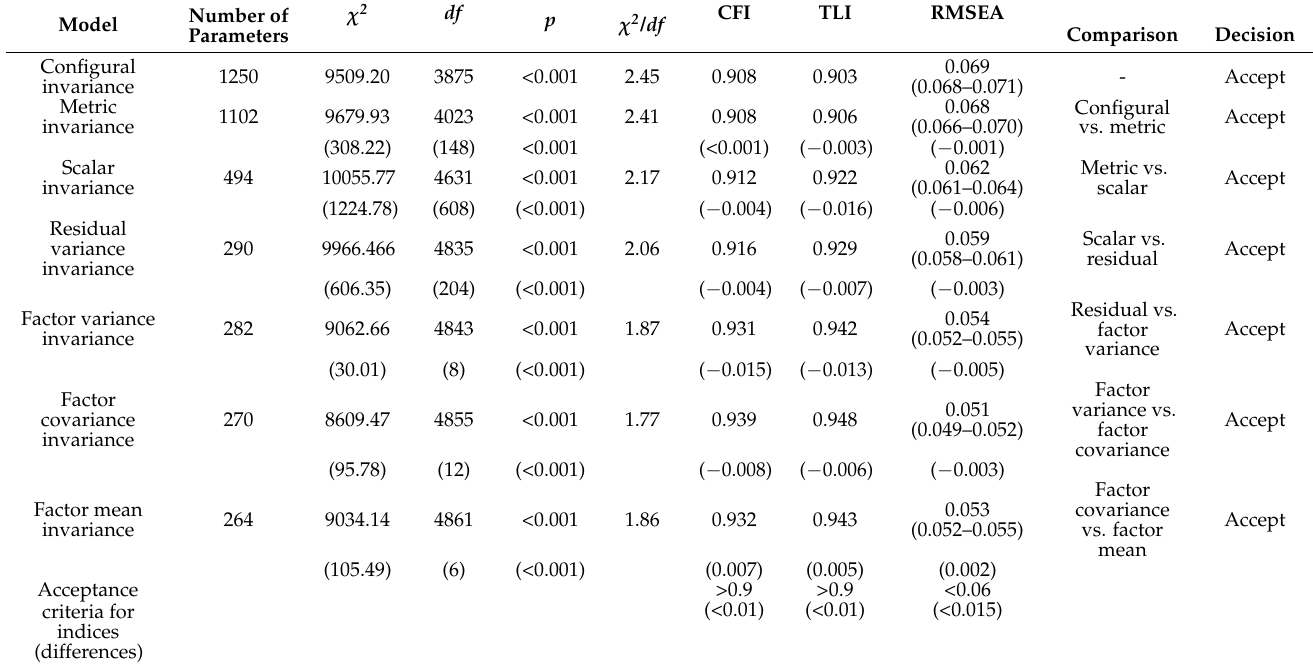
Table 6. MG CFA Results Using Mothers Samples from USA, South Africa, Nigeria, India, and Malaysia.